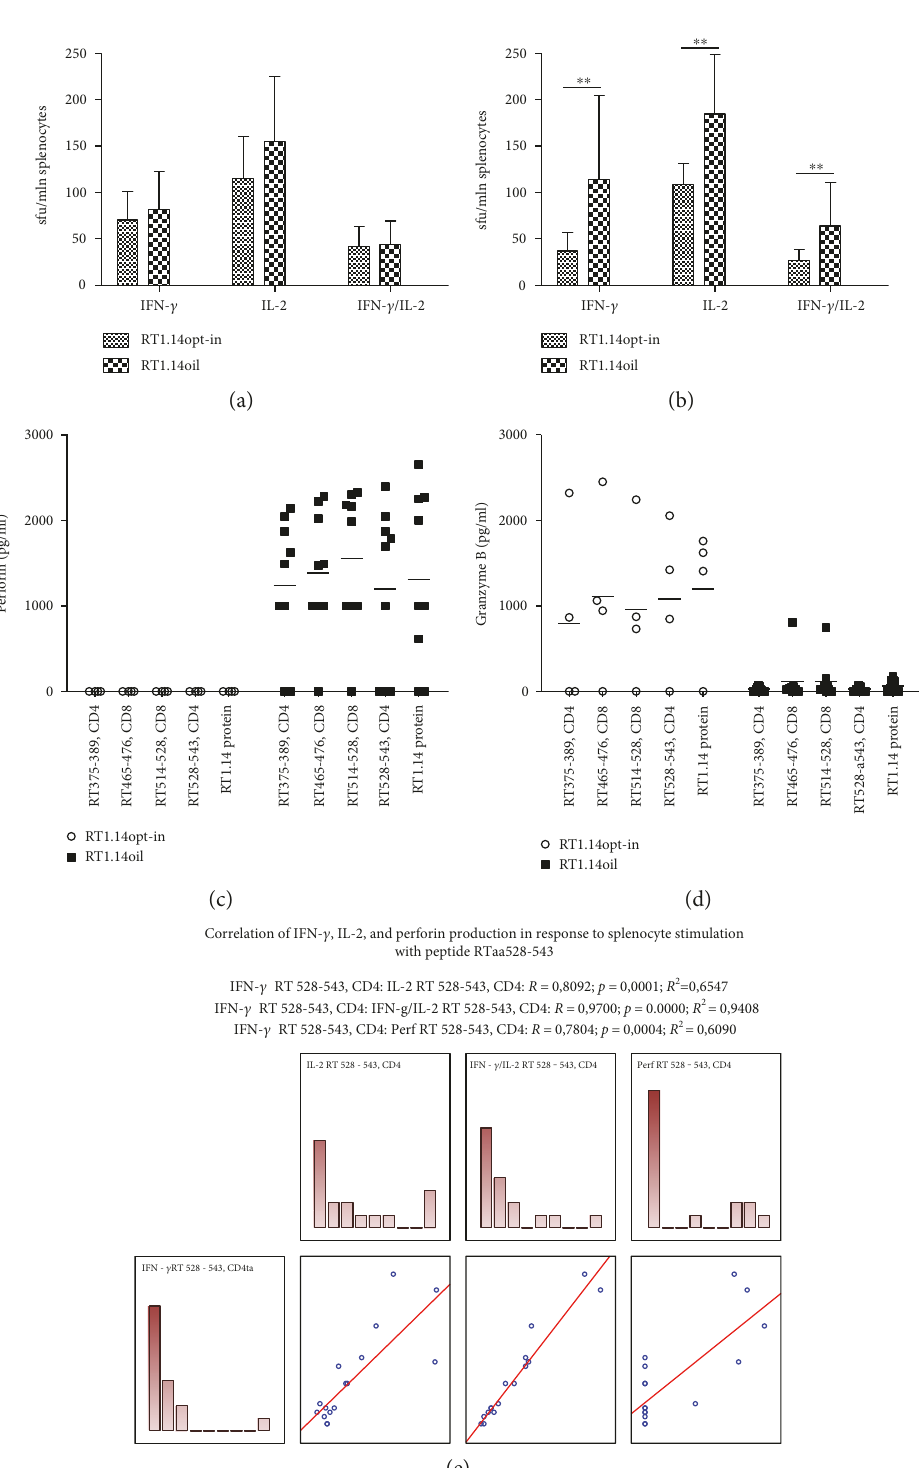
Figure 7: Cellular immune response of mice immunized with pVaxRT1.14opt-in and pVaxRT1.14oil. IFN- γ , IL-2, and dual (IFN- γ /IL-2) secretion by splenocytes in response to stimulation with RT1.14 protein (a) or RT1.14-derived peptide aa528-543 (b) measured by Fluorospot. Responses represent the average number of signal-forming units (sfu) per mln cells in two independent experiment runs, each done in duplicate, +SD, n = 4 , ∗∗ p < 0 1 (Mann – Whitney test). Secretion of perforin (c) and granzyme B (d) by splenocytes of mice immunized with pVaxRT1.14opt-in and pVaxRT1.14oil in response to stimulation with RT1.14 protein and RT1.14-derived peptides. Splenocytes were stimulated with the recombinant RT 1.14 protein and RT peptides for 3 days. After that, cell culture fl uids were collected and subjected to the analysis for granzyme B and perforin by sandwich ELISA. Data represent an average value of two repeated measurements for each mouse, in pg/ml. Correlation of the parameters of cellular immune response